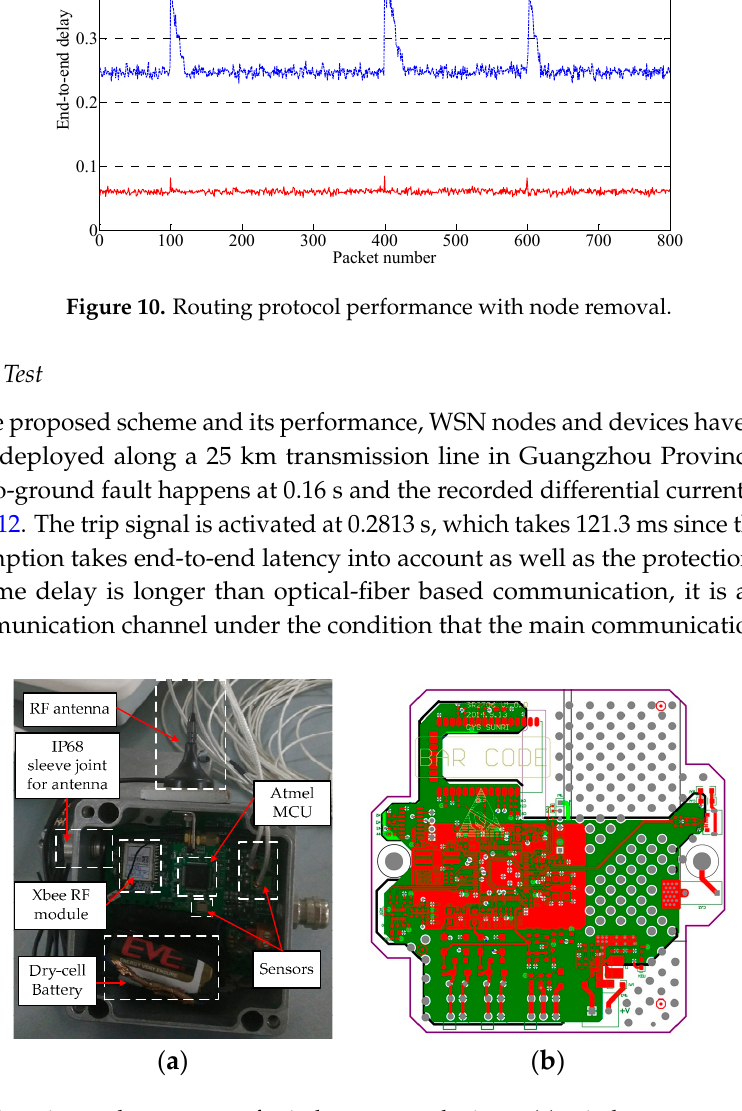
Figure 11. Experimental prototype of wireless sensor devices. ( a ) wireless sensor node in shell; and ( b ) and printed circuit board (PCB) design of wireless sensor module.